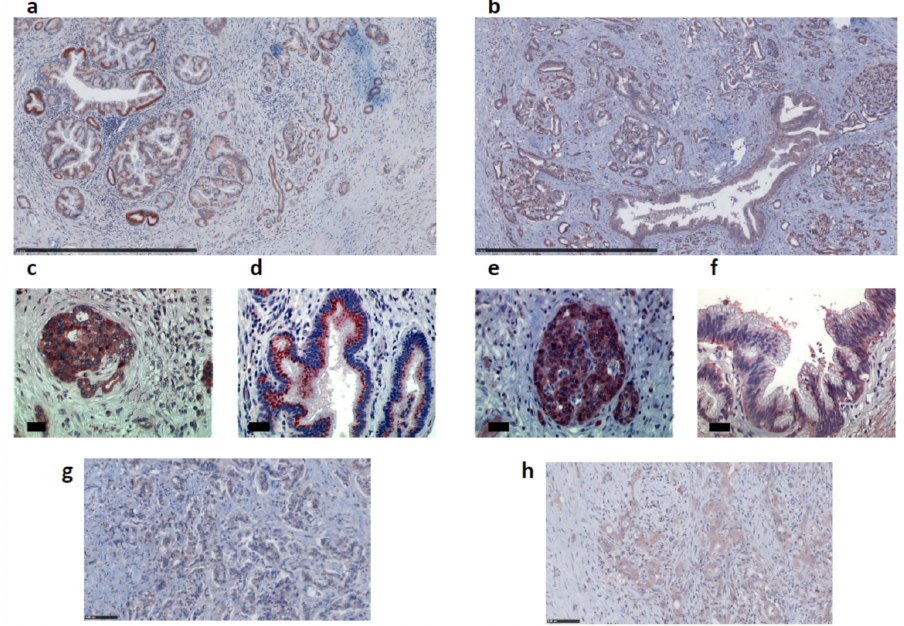
Figure 2. Apelin and APJ are expressed in human premalignant and malignant pancreatic lesions. Representative immunohistochemistry stainings of apelin ( a ) and APJ ( b ) on human PDAC. Scale bars, 1 mm. Apelin ( c ) and APJ ( e ) are expressed in islets of Langerhans. High magnification of apelin ( d , g ) and its receptor ( f , h ) immunostaining in PanIN lesions ( d , f ) and in poorly differentiated pancreatic tumors ( g , h ). Scale bars, 34 µ m (c–f) or 100 µ m ( g , h